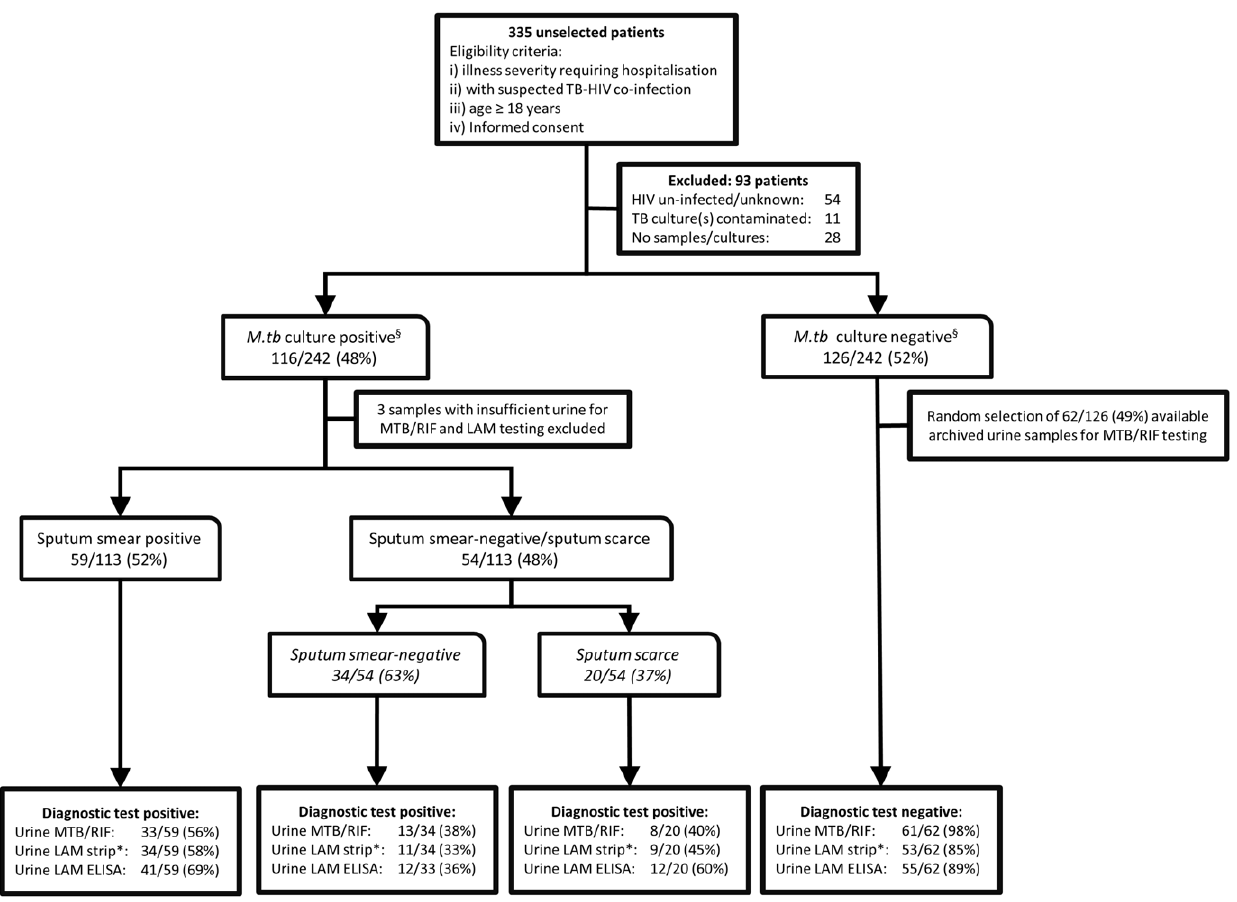
Figure 1. Study flow diagram. 1 Both sputum and non-sputum samples (e.g. blood, pleural or pericardial fluid) were collected by attending clinicians for liquid TB culture. M.tb culture positive patients had at least one sputum or non-sputum sample liquid culture positive, while m.tb culture negative patients had at least one (usually 2 or more) samples liquid culture negative *Results using a grade 2 cut-point for the urine LAM strip test are shown. (sputum scarce). 52% (59/113) of TB patients were sputum smear- positive.